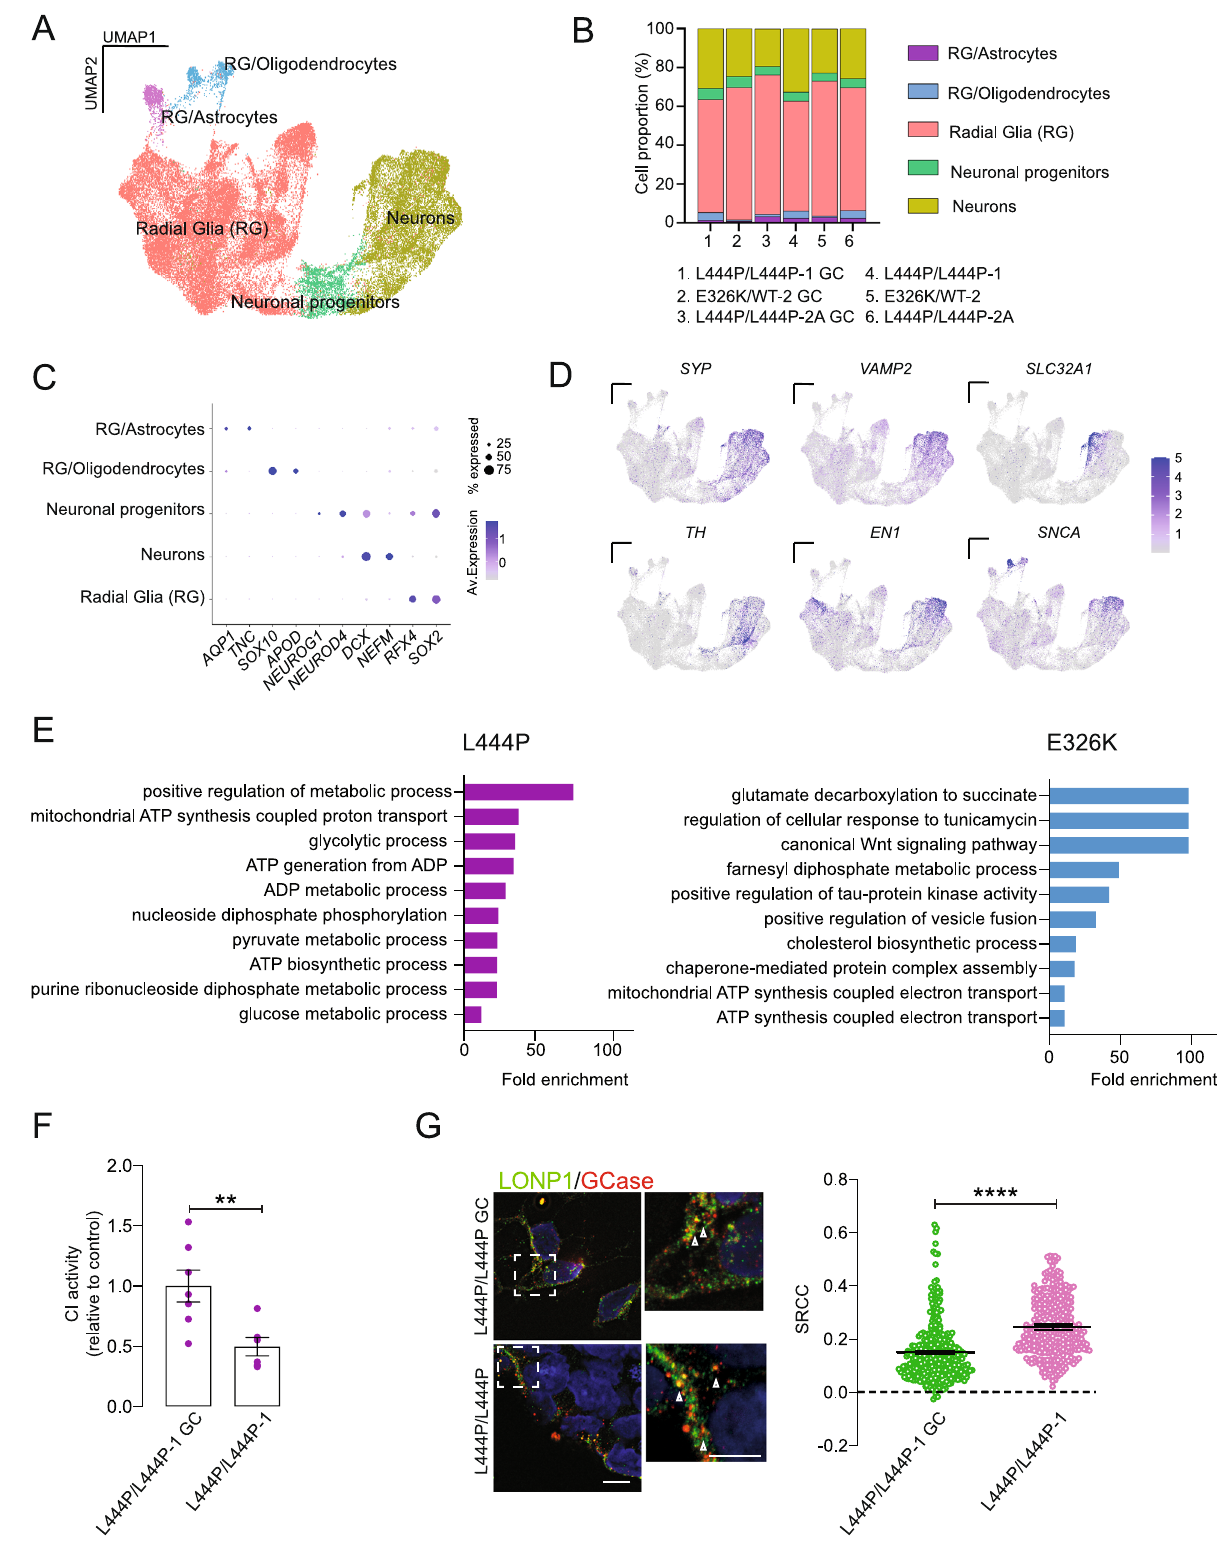
iMTS-ls pro fi le generation Internal N-terminal matrix-targeting-like signal (iMTS-ls) analysis protein sequences were generated by sequentially removing N-terminal amino acids. GCase suf fi x sequences were then subjected to TargetP prediction (TargetP 2.0) in standard FastA